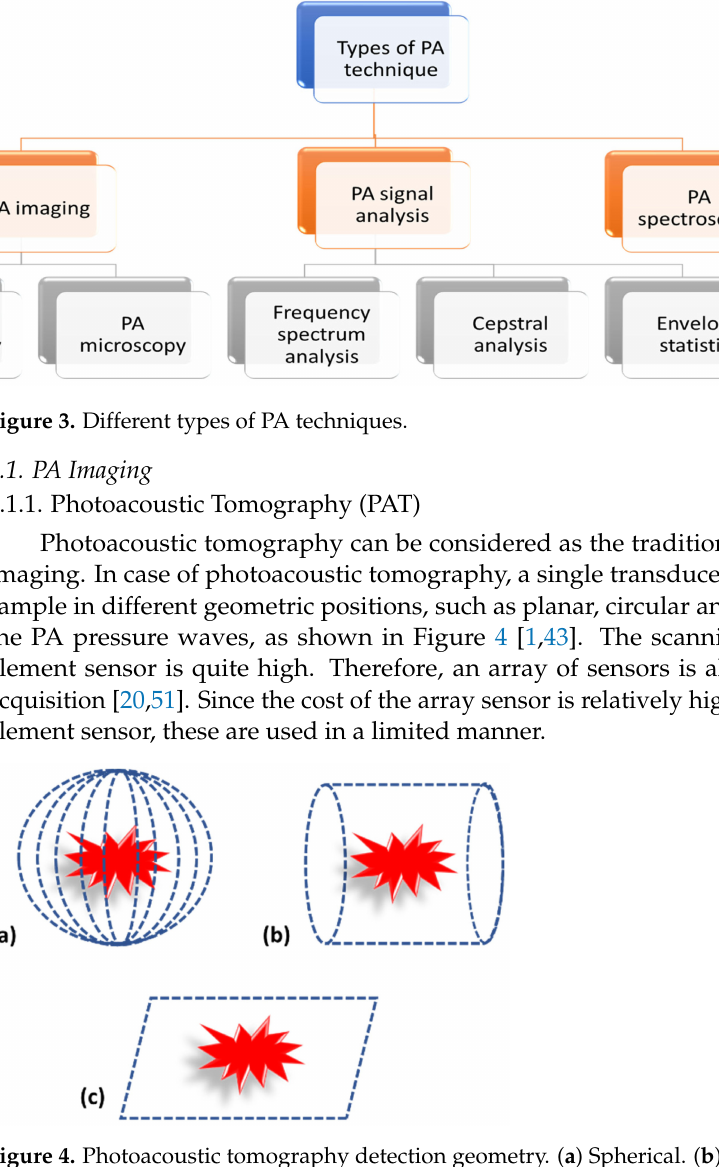
Figure 4. Photoacoustic tomography detection geometry. ( a ) Spherical. ( b ) Cylindrical. ( c )